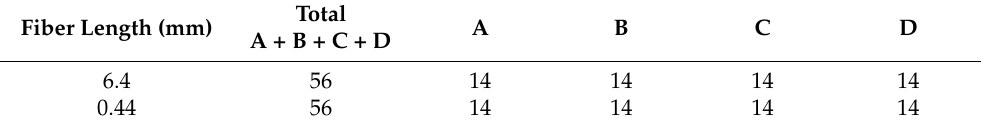
Table 4. Number of GFRP-BMC samples tested.